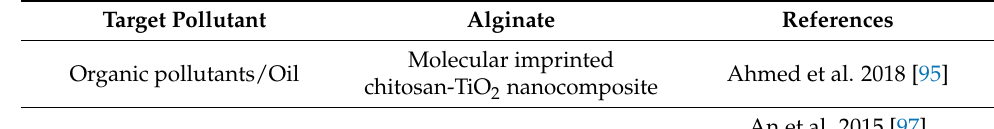
Table 5. Alginates’ potential in pollutants’